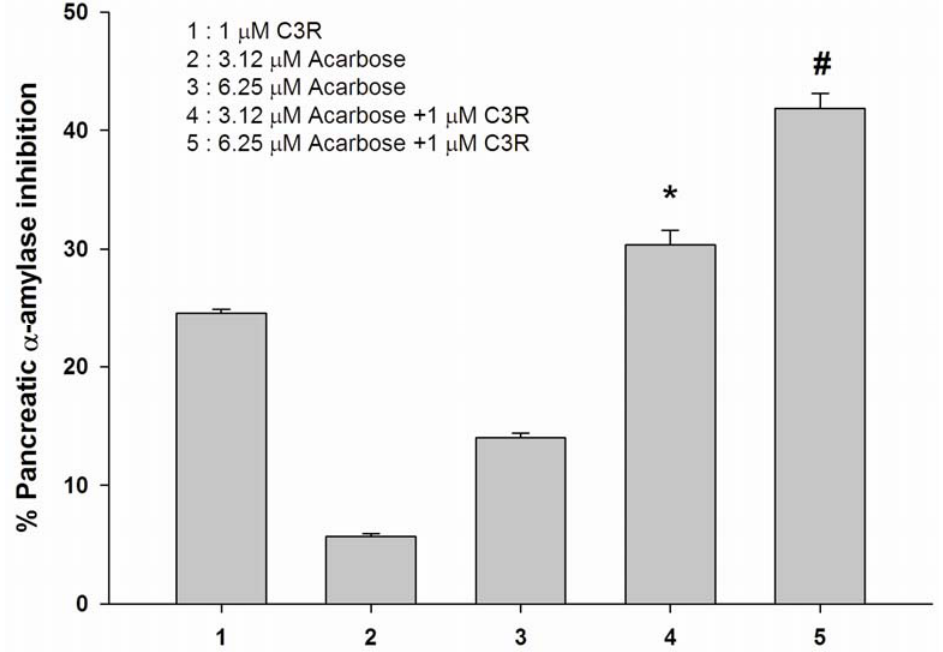
Figure 3. The combined effect of acabose and C3R (1 μ M) on inhibition of pancreatic α - amylase. Result are expressed as means ± S.E.M; n = 3. * P < 0.01 compared with acarbose (3.12 μ M) and # P < 0.01 compared with acarbose (6.25 μ